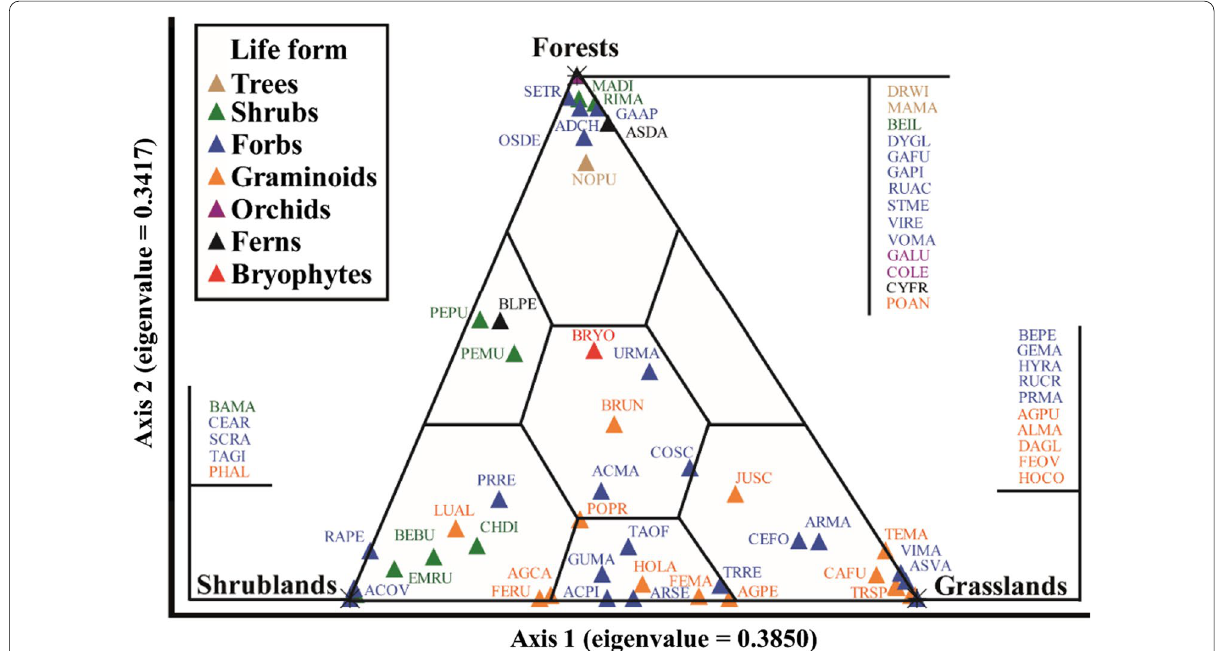
Fig. 2 Detrended correspondence analysis (DCA) to show forage offer by vegetation type, based on the cover (%). Plant species are classified by life forms, and codes are shown in Appendix 1. BRYO corresponded to Bryophytes (as a one whole